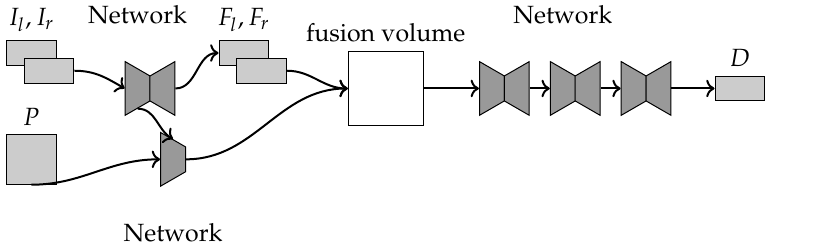
Figure 12. The inputs shown are the point cloud P and the left–right RGB image pair I l , I r used to compute feature maps F l , F r , and the final depth map D is computed from the fusion volume.